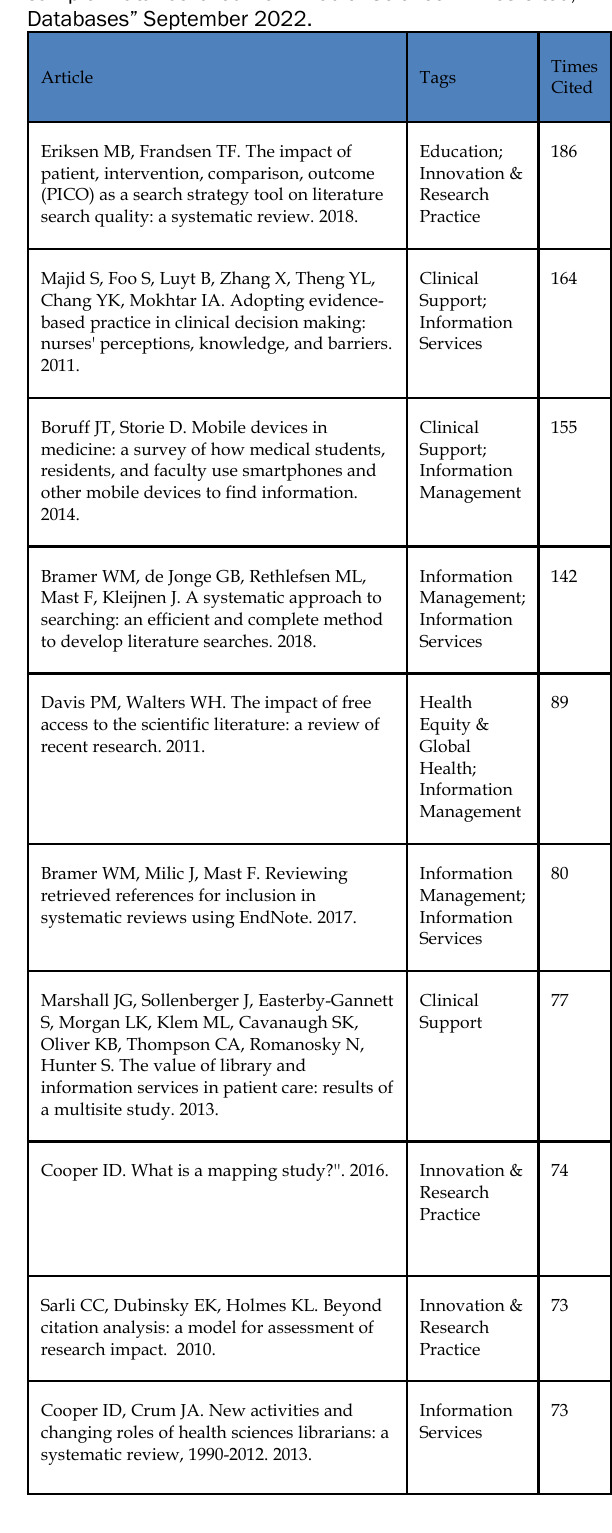
Table 2: The top ten most highly cited articles in the